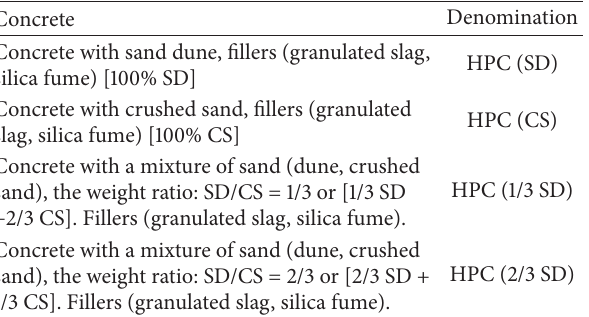
Figure 5: Variation of W/C for various percentages of crushed